Question: Which kind of chart has been used to present this data?
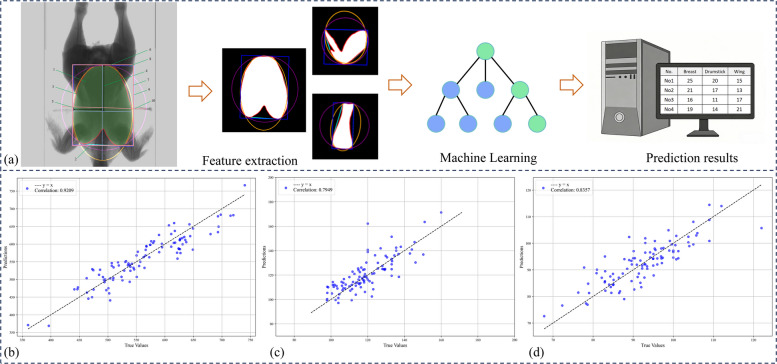
Answer: scatter